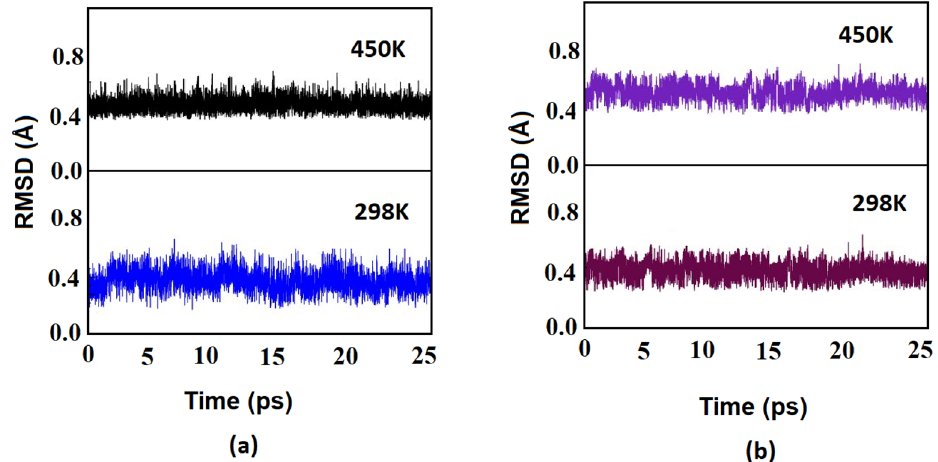
Figure 7. Plot of RMSD (Å) versus time (ps) obtained from BOMD simulation (M06-2X/TZVP) at 298 K and 450 K for ( a ) Cu 5 Al 2+ and ( b ) Cu 5 Ga 2+